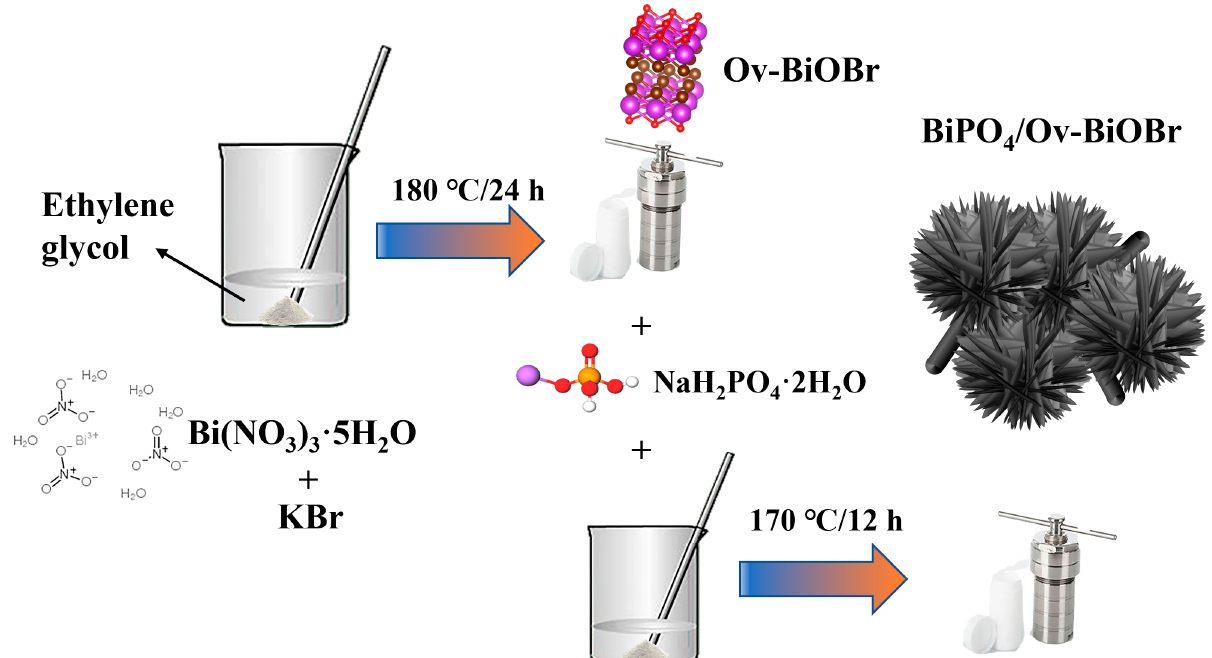
Figure 13. Preparation process of BiPO 4 /Ov-BiOBr composite photocatalyst.